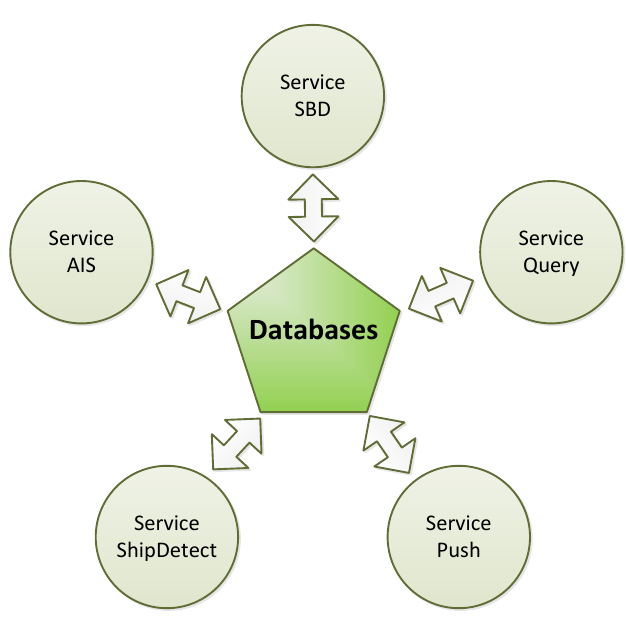
Figure 4. Top level overview of the AMARO software